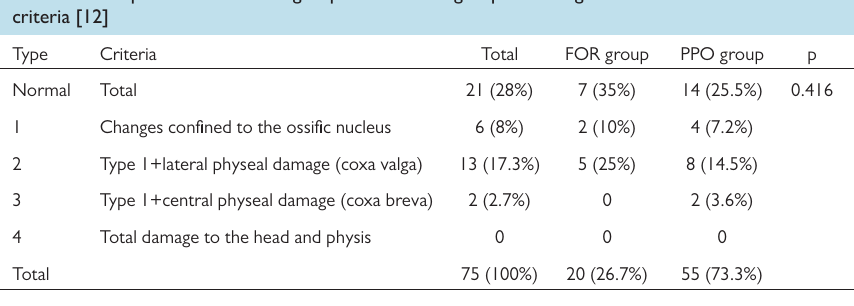
Table 4. Comparison of the rate of revision surgery after the FOR group and the PPO group Tonnis type